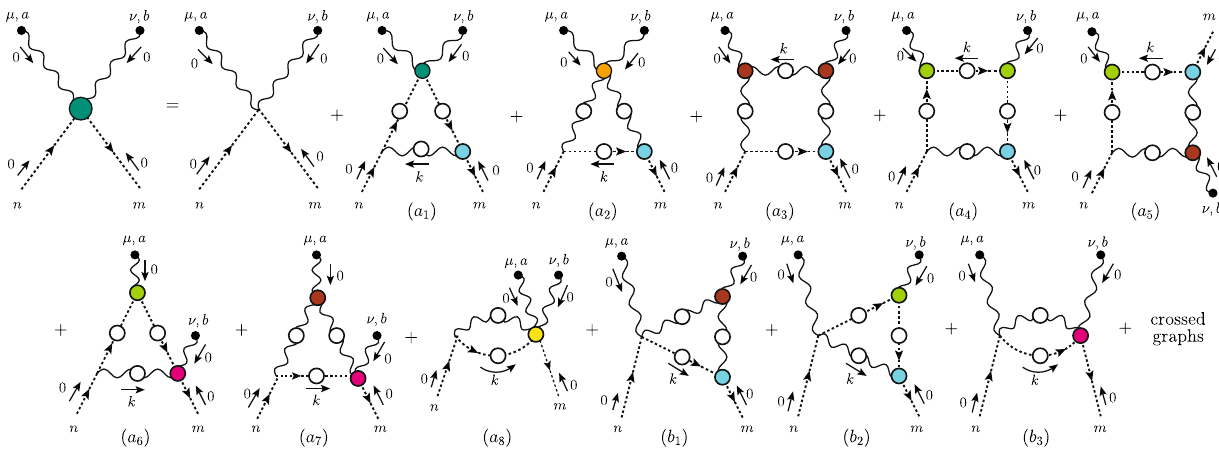
Fig. 5 The diagrammatic representation of the SDE for the vertex BB ¯ cc, expanded in terms of 1PI vertices; crossed diagrams are not shown. Note that diagrams ( a i ) with i = 1 , 2 ,..., 8 originate from the expansion of the 1PR kernel in a in Fig. 3, while ( b i ) with i = 1 , 2 , 3 come from b ( 0 ) Turning to ( b 1 ) , the term (cid:2) νρσ ( 0 , k , − k ) of the BFM (cid:4) (cid:2) ( 0 ) ( 0 , k , − k ) simply yields the tree-level vertex νρσ